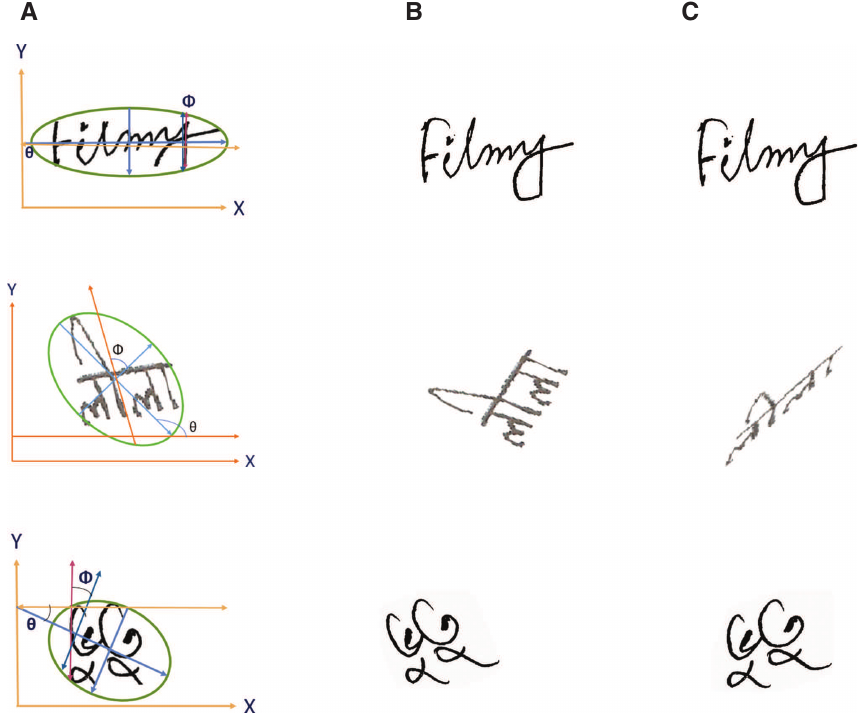
Figure 13: Limitations of Our Approach. (A) Improper ellipse fitting on approximate core region of input word. (B) Results after slope correction. (C) Results after slant correction of two critical